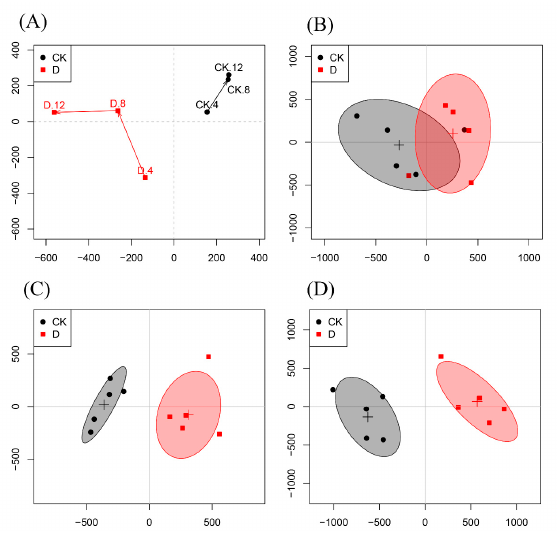
Figure 4. ( A ): Score trajectory of the OSC-PLS-DA analysis in the CK group and D group at 4, 8, 12 h. ( B – D ): Scores plots of CK and D groups at 4 h, 8 h, and 12 h, respectively. In the 12 h S-plot (Figure 5B), different shapes and colors of the dots show different metabolites. The contribution of these metabolites to the group is related to their distance to the center; variables farther away from the center contribute more to the group separation. On the basis of the correlation coefficient, the 12-hours loading plots (Figure 5C,D) are coded with cold and warm tones, and the correlation increases gradually from blue to red. Significant decrease of lactate, alanine, glutamate, glutamine, glutathione, aspartate, sarcosine, phenylalanine, ethanolamine, choline, arginine, methanol, glycine, π -Methylhistidine and xanthine, and marked increase of leucine, uracil, tryptophan and adenine were found in the carvacrol dosed group. Appl. Sci. 2019 , 9 , x FOR PEER REVIEW